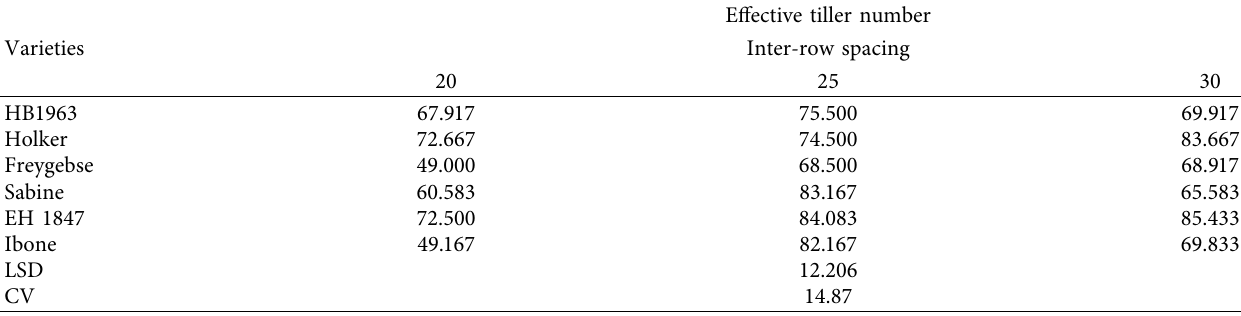
LSD � list significant difference; CV � coefficient of variation.